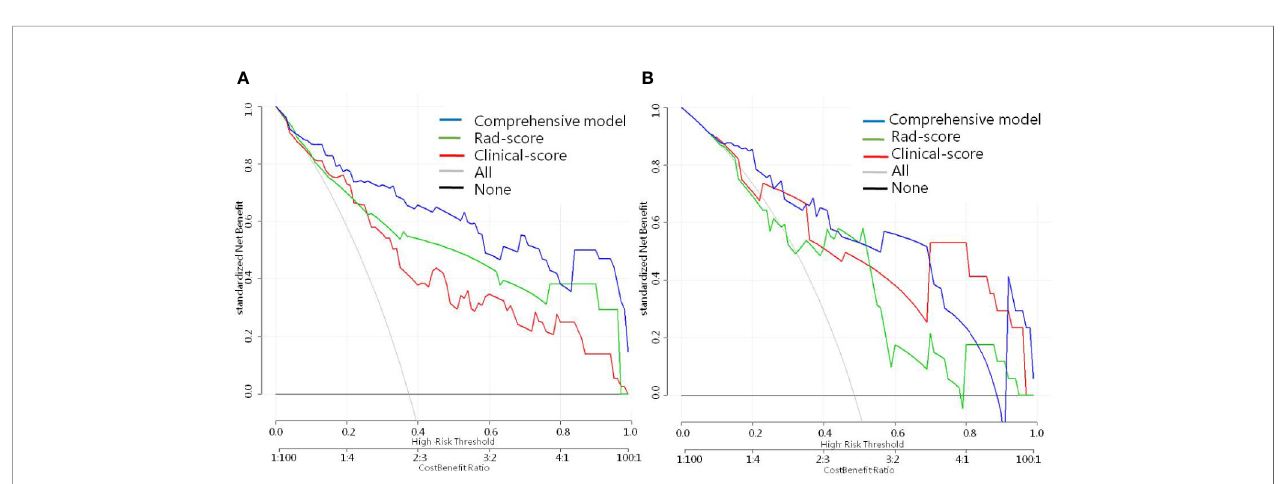
FIGURE 4 | Decision curve analysis for every model in (A) the training and (B) validation dataset. The net bene fi t is measured by the y-axis, which is calculated by summing the bene fi ts (true-positive fi ndings) and deducting the harms (false-positive fi ndings), while weighting the harms associated to the relative damage of undetected IHL-ICC when compared with the damage of being mistakenly diagnosed with HL-ICC.